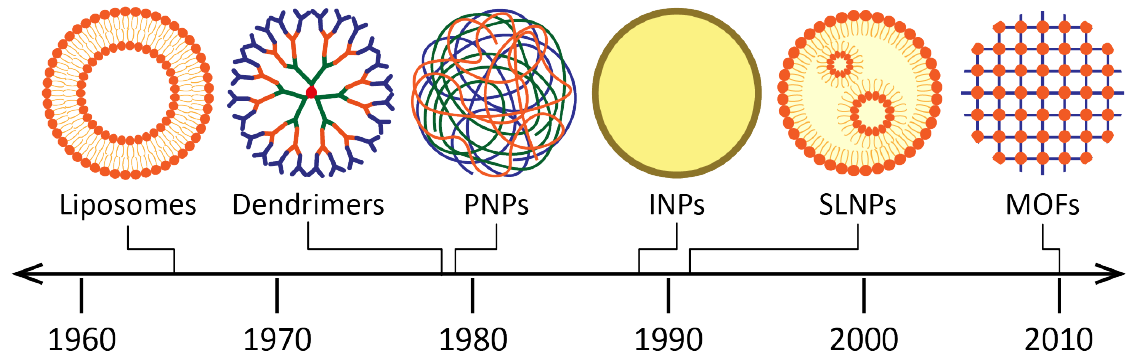
Figure 5. Schematic representation of the main nanosized drug delivery systems for biomedical applications discovered over time. PNPs: polymeric nanoparticles; INPs: inorganic nanoparticles; SLNPs: solid lipid nanoparticles; MOFs: metal–organic frameworks.